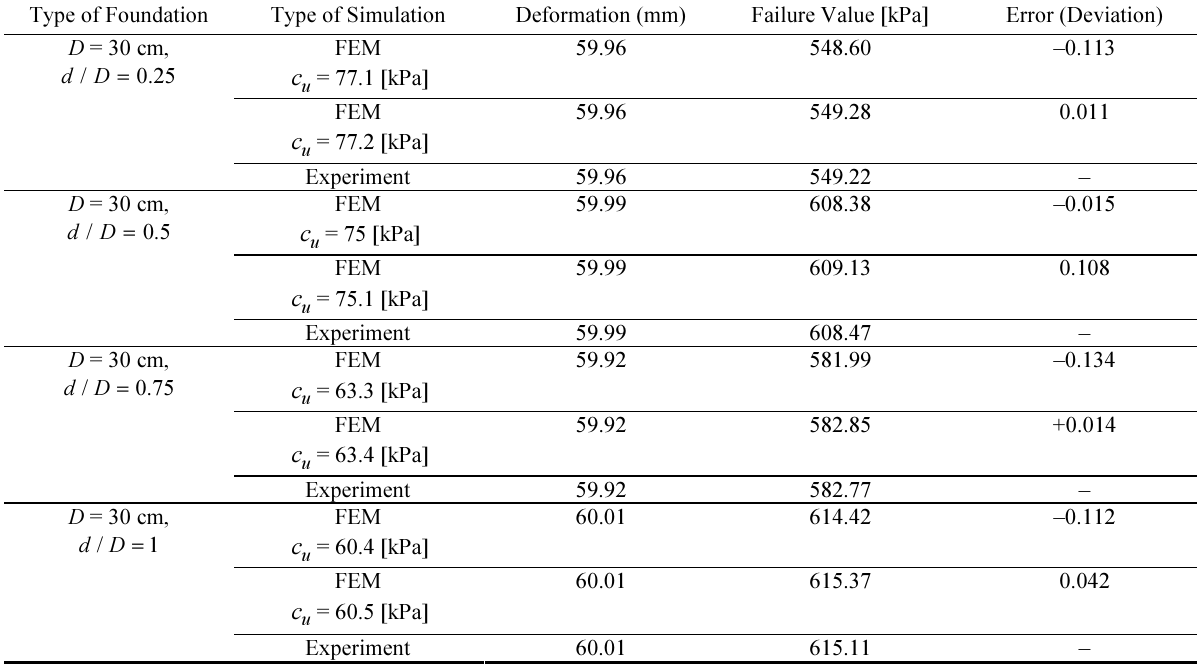
Table 10. Results of best-fit finite element simulations Type of Foundation